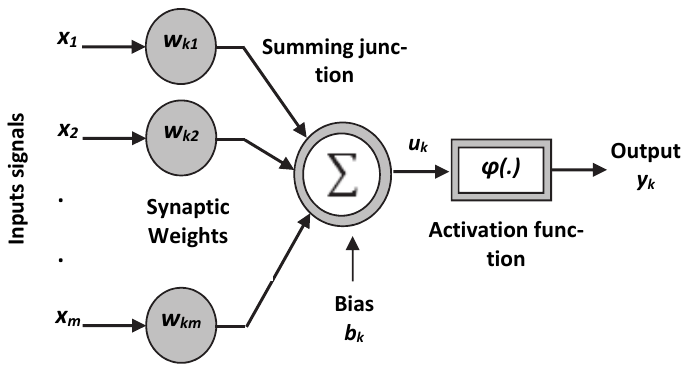
Fig. 2. Non-linear model of a neuron (Haykin,